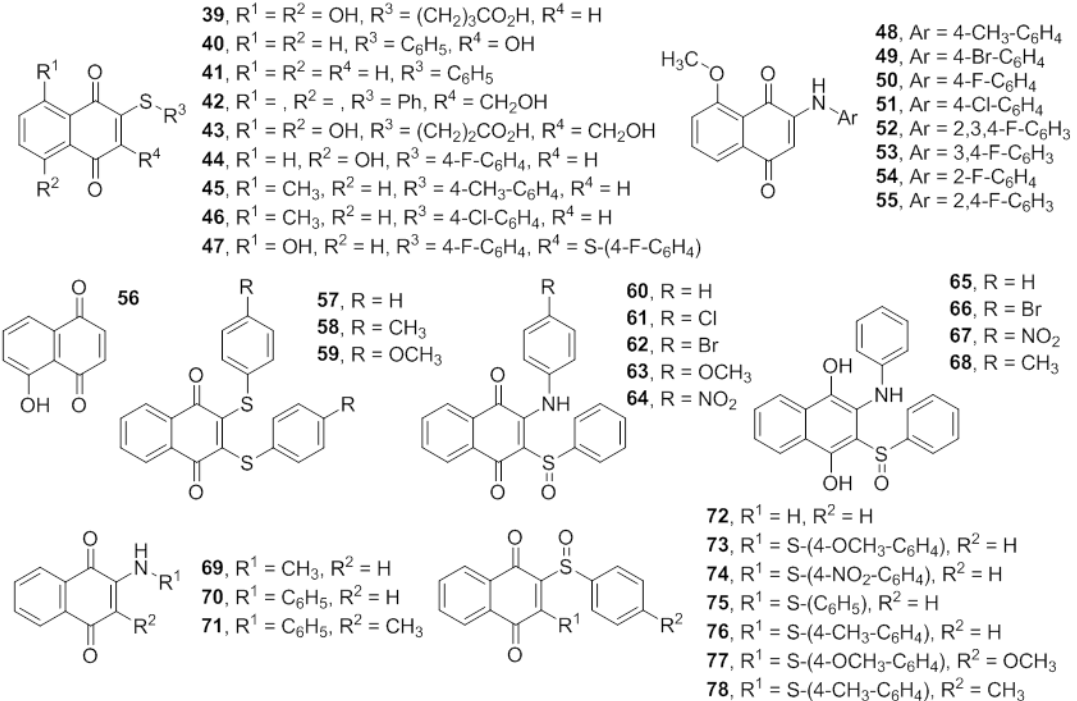
Figure 5 - a (Entry 39 – 56) – Some naphthoquinones active against C. albicans , C. neoformans , S. schenckii , T. mentagraphytes , M. cannis and A. fumigatus ; b (Entry 57 – 78) – Sulfides, sulfoxide and amino-1,4-naphthoquinones with activity against some Candida